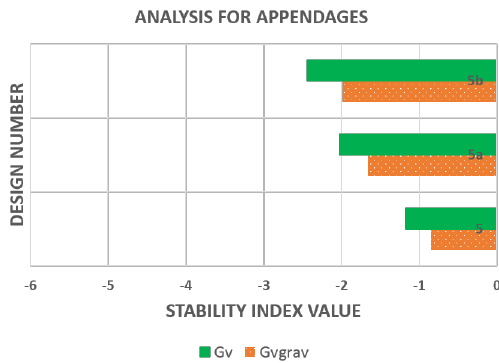
Figure 8. Stability indices for sail contribution.